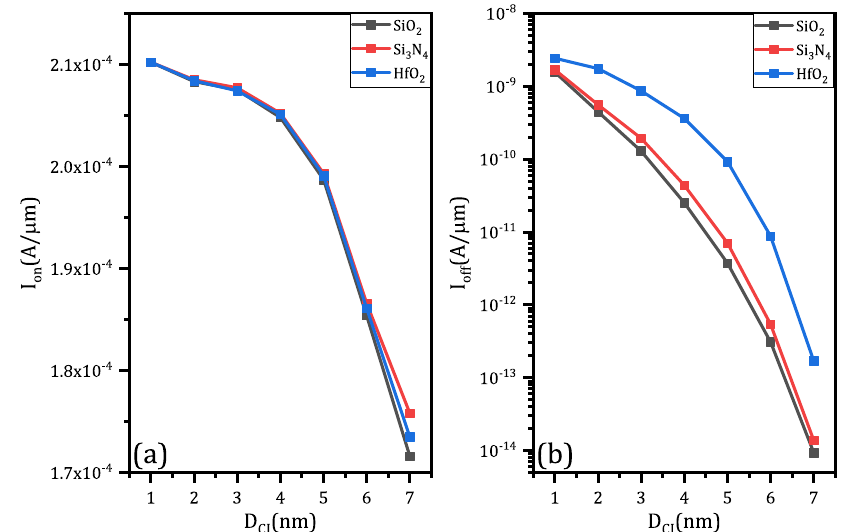
Figure 8. The simulation results of CIGAA and GAA in terms of different Core–Insulator material and D CI : ( a ) on-state current. ( b ) off-state current. Both figures are plotted when D NW is fixed to 8